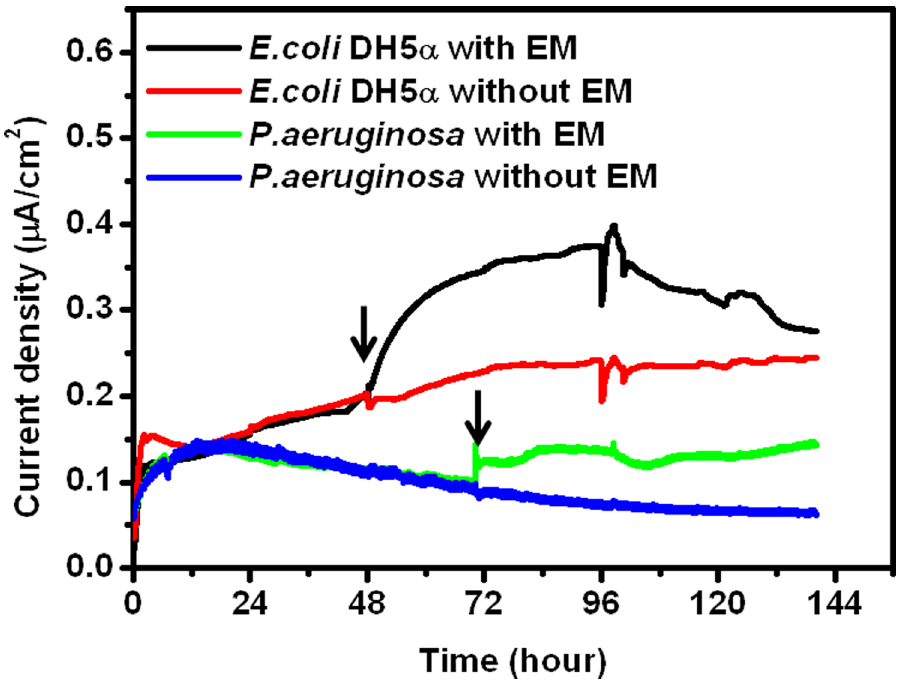
Fig 6. Current density vs. time plots of E . coli DH5 α and P . aeruginosa lasIrhlI mutant – based MFCs. EM stands for extracellular metabolites of A . andensis ANESC-S T (2.5 mg/mL). Arrows indicate introduction of EM. Data represents an average of triplicates.